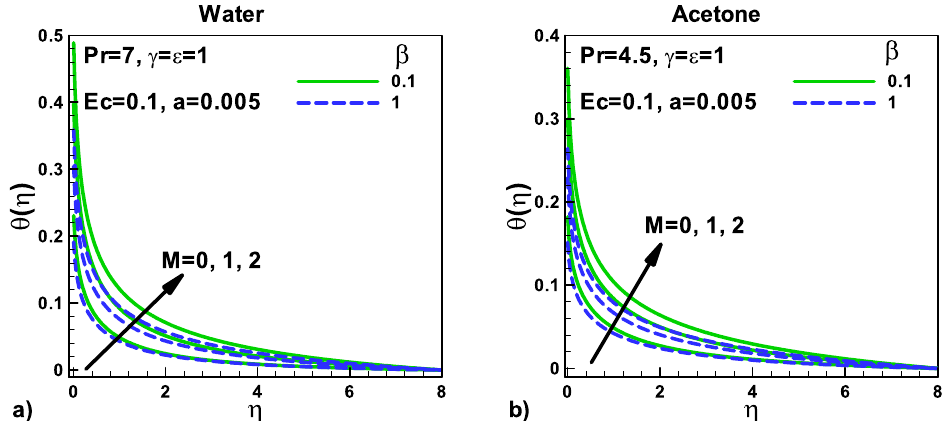
Figure 5. Effects of velocity slip and magnetic parameters on dimensionless temperature for ( a ) water ( b ) Acetone.